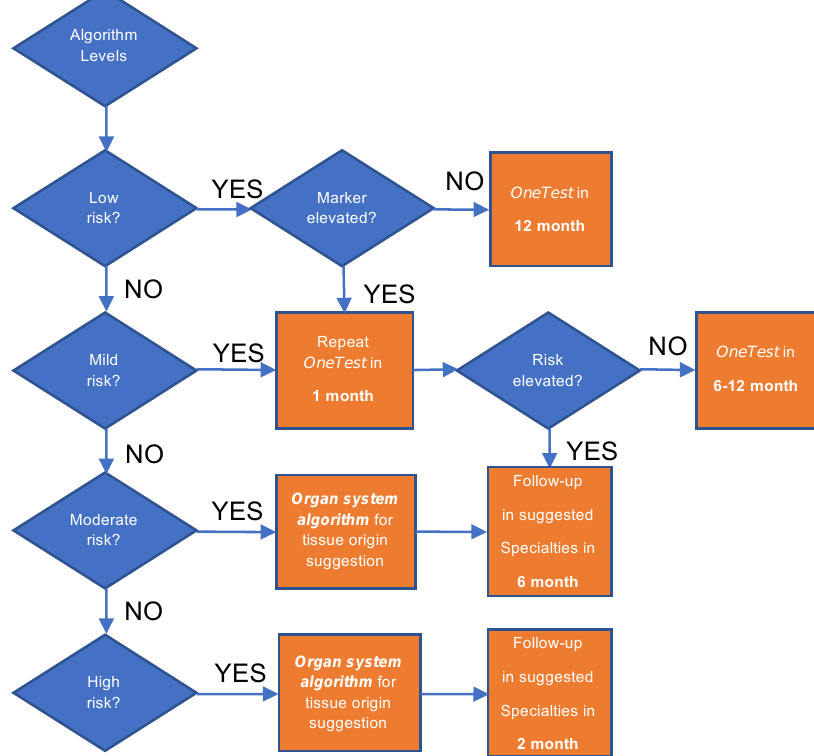
Figure 5. Actionable recommendation for the different levels of risk scores. When low risk is reported and all the biomarkers are below the reference ranges, 1-year follow-up is recommended. For the low risk group whose marker is elevated and for the mild risk group, 1-month repeat is recommended to exclude an elevated risk caused by interference. For the individuals whose risk score keeps elevating upon repeat and for the moderate risk group, 6-month follow-up in the suggested specialties (i.e., top 3 most likely a ff ected organ systems provided by the Organ System Algorithm) is recommended. For the high risk group, 2-month or shorter follow-up is recommended for further investigation of